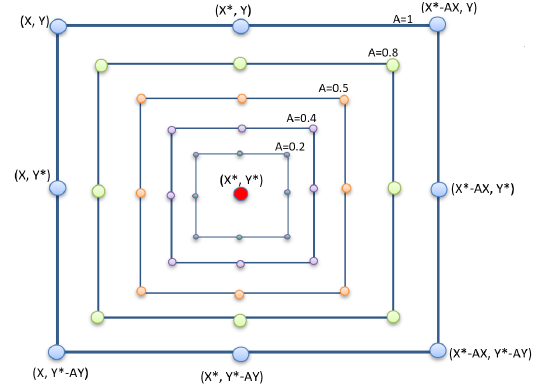
Figure 5. Shrinking encircling